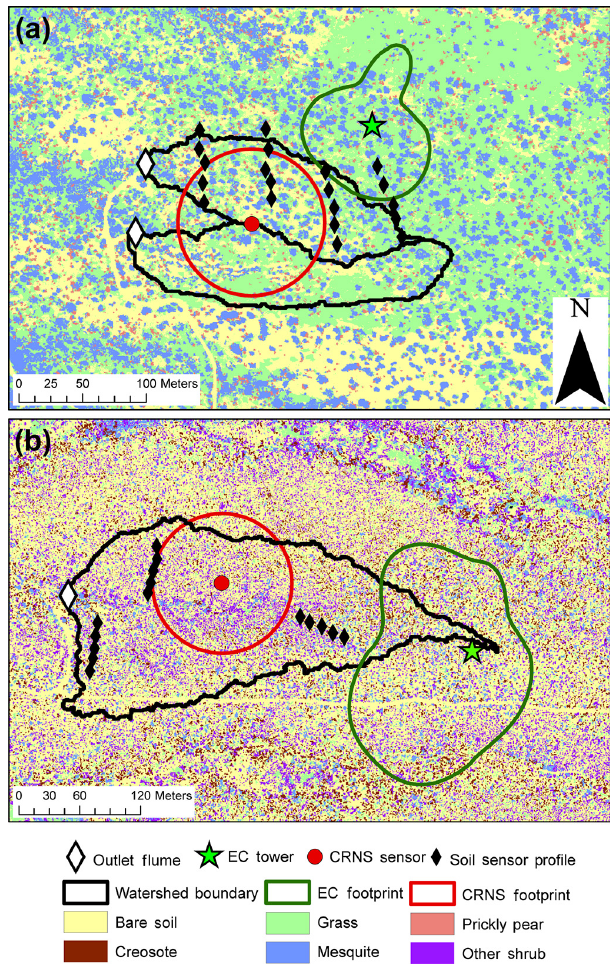
Figure 2. Vegetation classification for (a) SRER and (b) JER de- rived from aerial image analyses along with sensor locations and the 50% contributing areas of the CRNS and EC